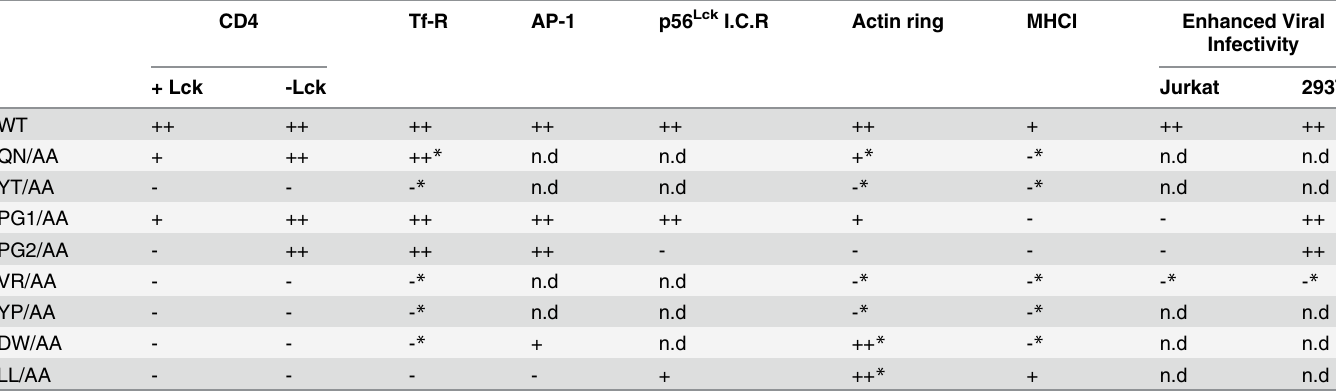
Table 2. Summary of Nef-activities related to